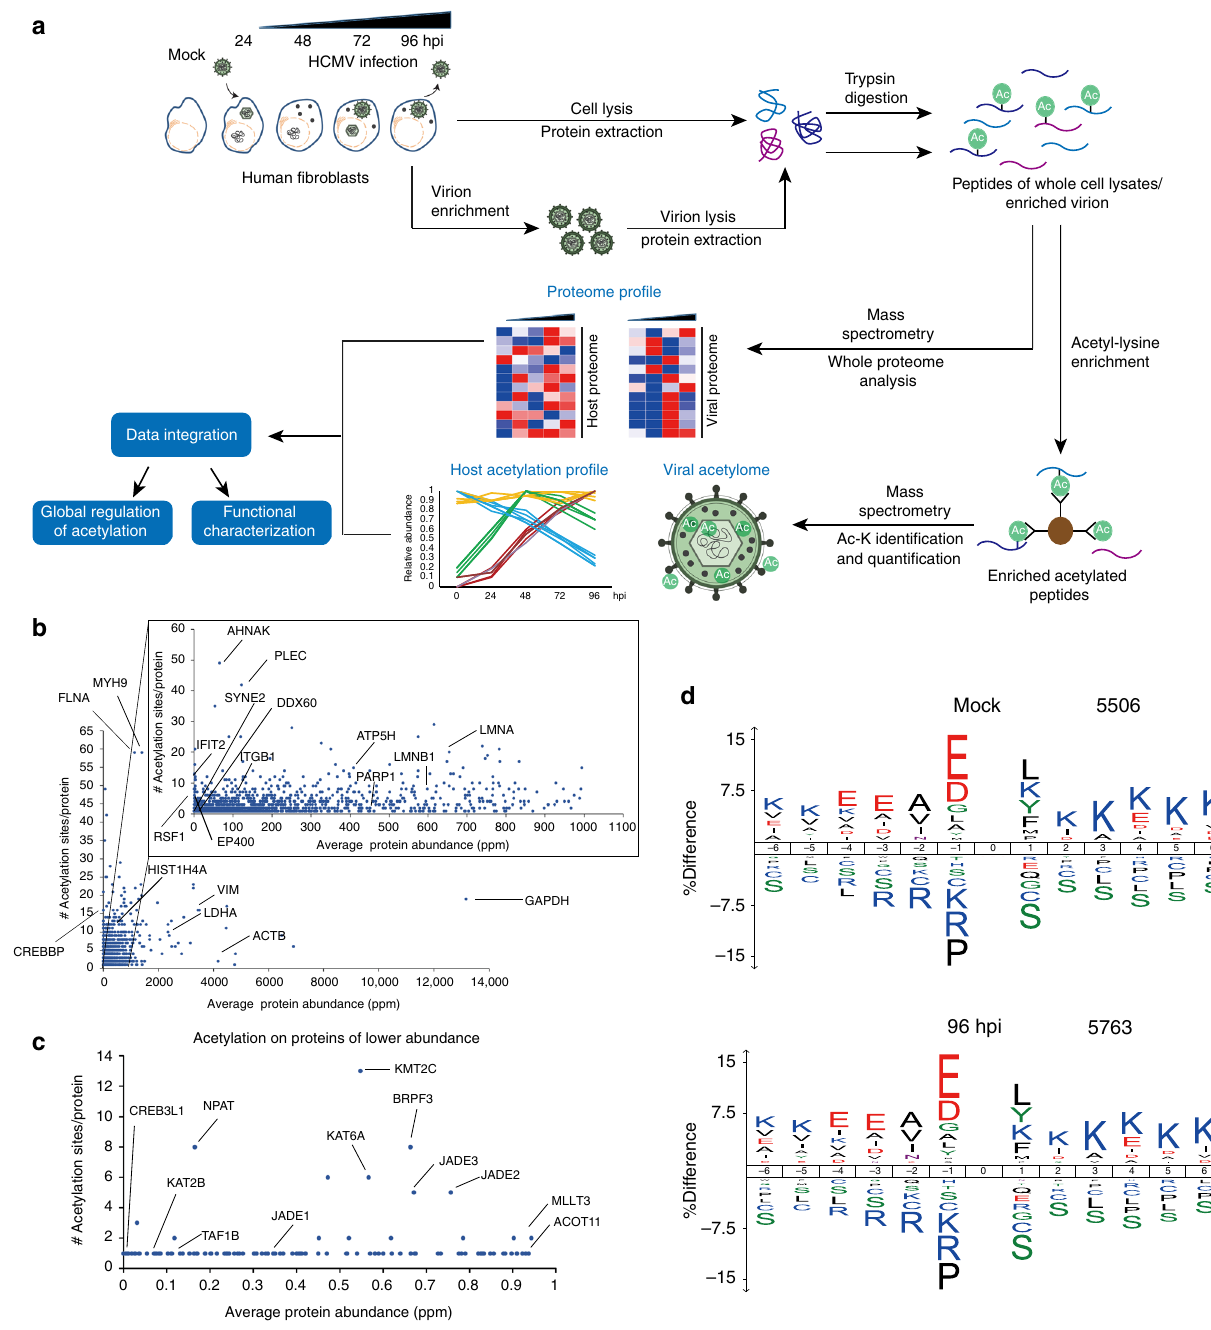
Fig. 2 Dynamic regulation and function of protein acetylation during HCMV infection. a Work fl ow of anti-acetyl lysine IP and MS from whole-cell lysate and enriched virions. b Investigating the relationship between number of acetylation sites and protein abundance. Average protein abundance in parts per million (ppm) sourced from PaxDB; Proteins in this database are scaled in ppm relative to the whole proteome of the reference data set; in this case, the abundances were drawn from the data set: H. sapiens – whole organism (integrated). c Examples of acetylations on low abundance proteins. d Acetylation motifs in uninfected (mock) and infected (96 hpi) cells, analyzed by IceLogo. Numbers of peptides used for motif analyses are indicated. Analysis of all time points is provided in Supplementary Fig. expressed at low levels or not at all in uninfected cells, the lack cells, we normalized their levels to protein abundance. This of detection of many acetylated peptides may represent either a normalization indicated that the increase in protein abundances speci fi c role during infection or their presence below the limit for IFIT proteins often outweighs the increase in acetylated of detection in uninfected cells (Fig. 3c). Consequently, for the peptide abundances (Fig. 3c, Supplementary Fig. 5b – d). The acetylated peptides detected only in infection (Fig. 3c, red fact that the majority of our identi fi ed acetylations on boxes), we visualized the changes on a 0 – 1 scale. However, for these proteins have not been previously reported (red lines) the acetylated peptides that were also detected in uninfected and were not detected in uninfected cells (red boxes) suggests